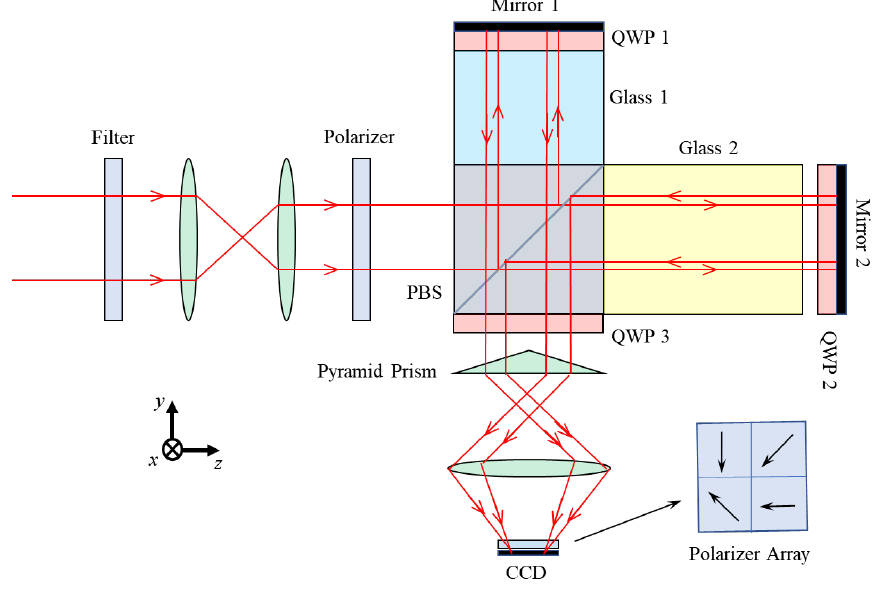
Figure 1. The system structure scheme of